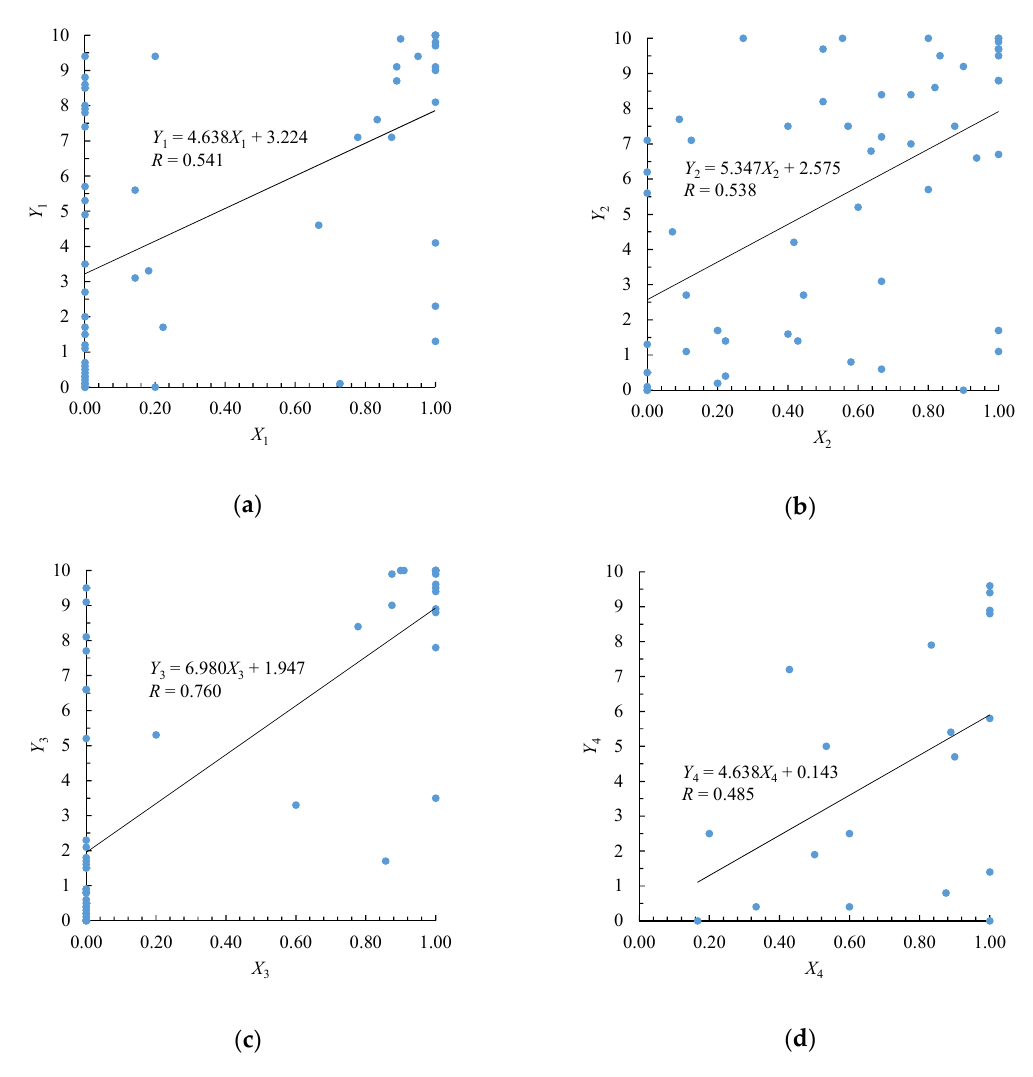
Figure 5. The relationship between the incidence rates of each of the profiles and the tactile score. ( a ) X 1 = incidence rates of the one-step increase pattern; Y 1 = score of the soft feel. ( b ) X 2 = incidence rates of the two-step increase pattern; Y 2 = score of the hard feel. ( c ) X 3 = incidence rates of the double peak pattern; Y 3 = score of the sticky feel. ( d ) X 4 = incidence rates of the drastic decrease pattern; Y 4 = score of the snapped feel.